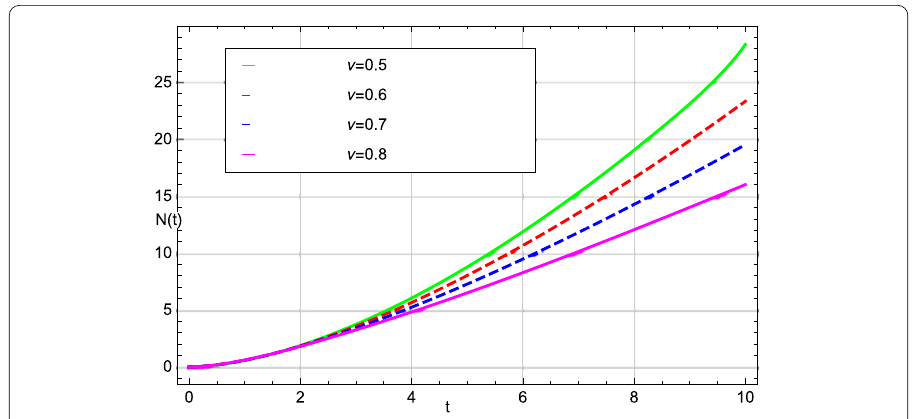
Figure 3 Solution (13) for N ( t ) and t